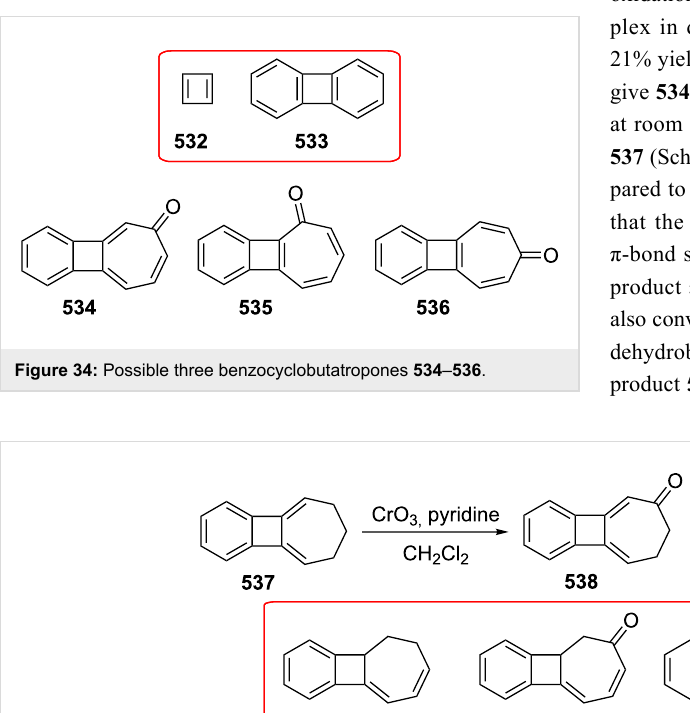
cyclobutatropones 535 and 534 , which possess a formal benzo- cylobutadienoid double bond, are also of particular interest.